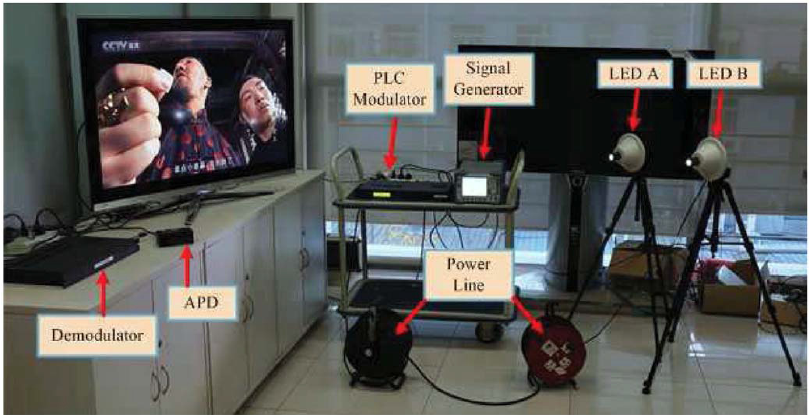
Figure 12. Demonstration setup of the PLC and IWOC broadcasting system in the laboratorial environment [15].